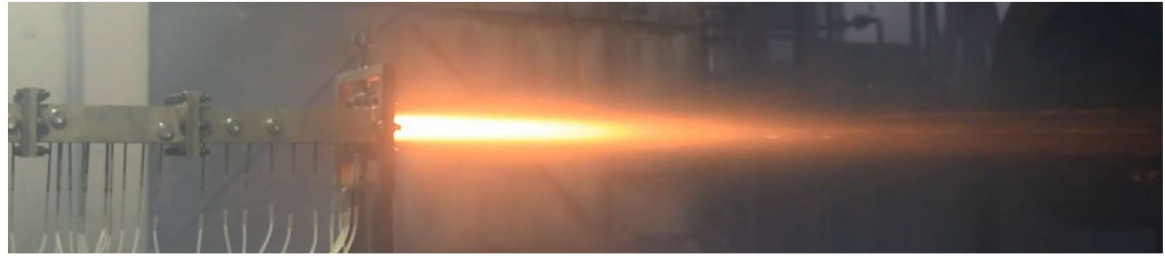
Figure 17. Flame at the outlet of the